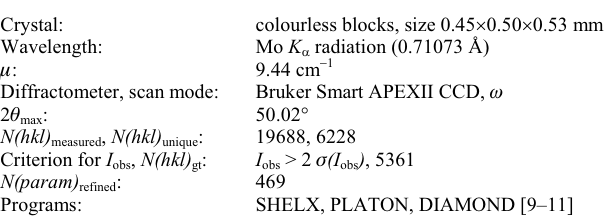
Table 1. Data collection and handling.